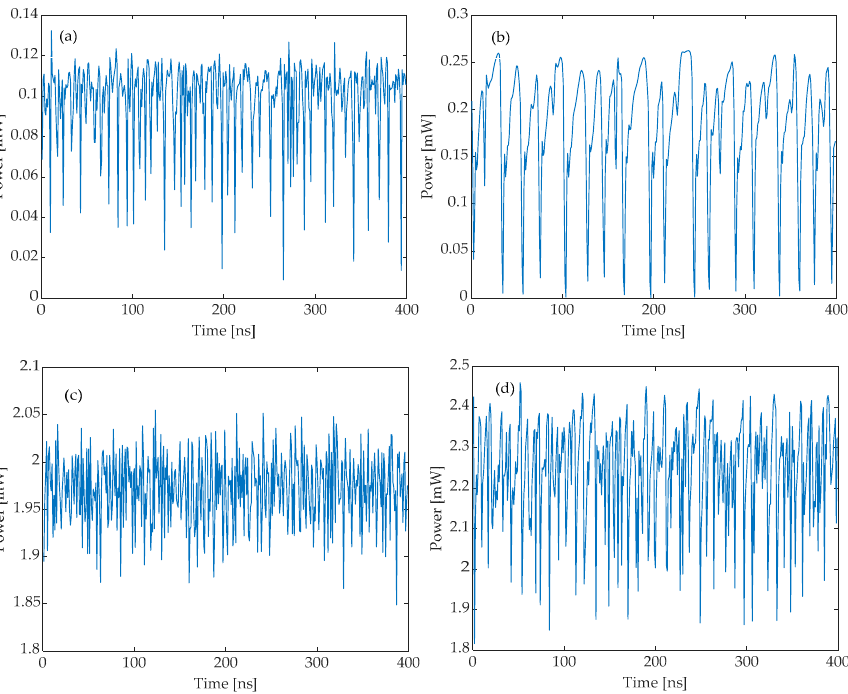
Figure 2. Output of the drive laser with optical feedback under different system parameters. ( a ) κ D = 10 ns − 1 and I D = 15 mA, ( b ) κ D = 50 ns − 1 and I D = 15 mA, ( c ) κ D = 10 ns − 1 and I D = 22 mA, and ( d ) κ D = 50 ns − 1 and I D = 22 mA.